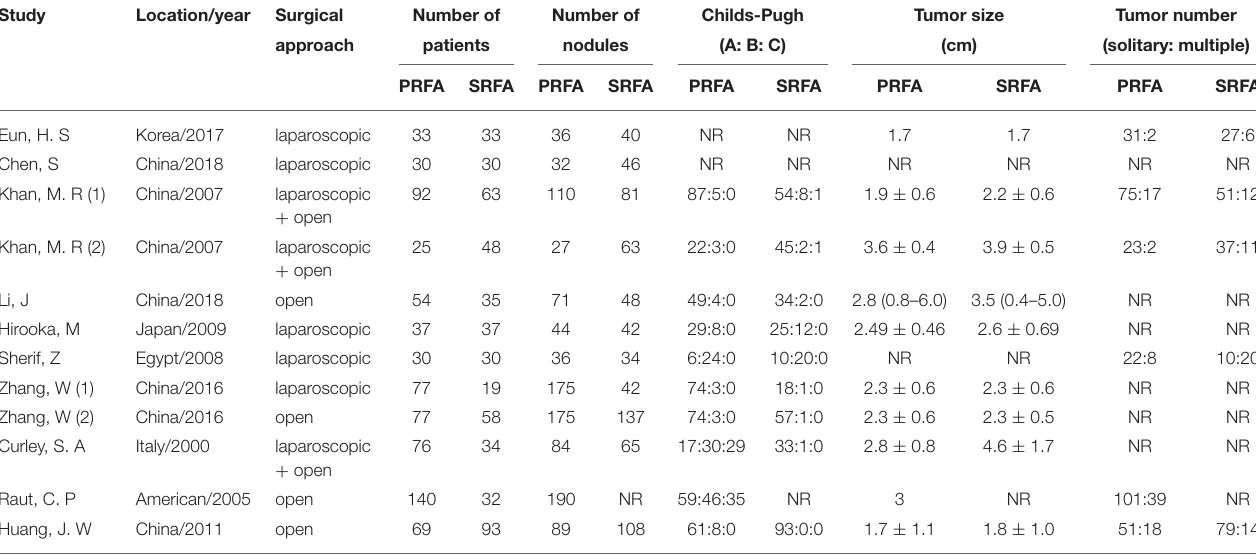
TABLE 1 | Summary of characteristics of included